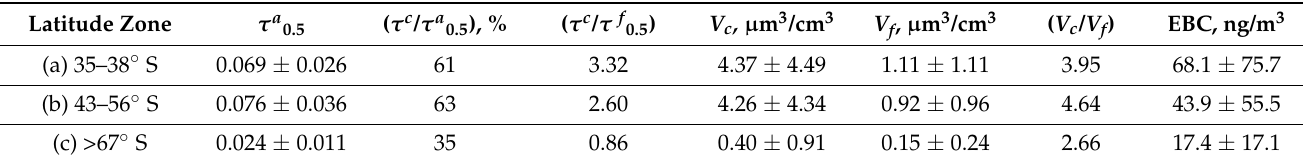
Table 1. Average values and standard deviations ( ± SD) of the aerosol characteristics in three latitudinal zones of the